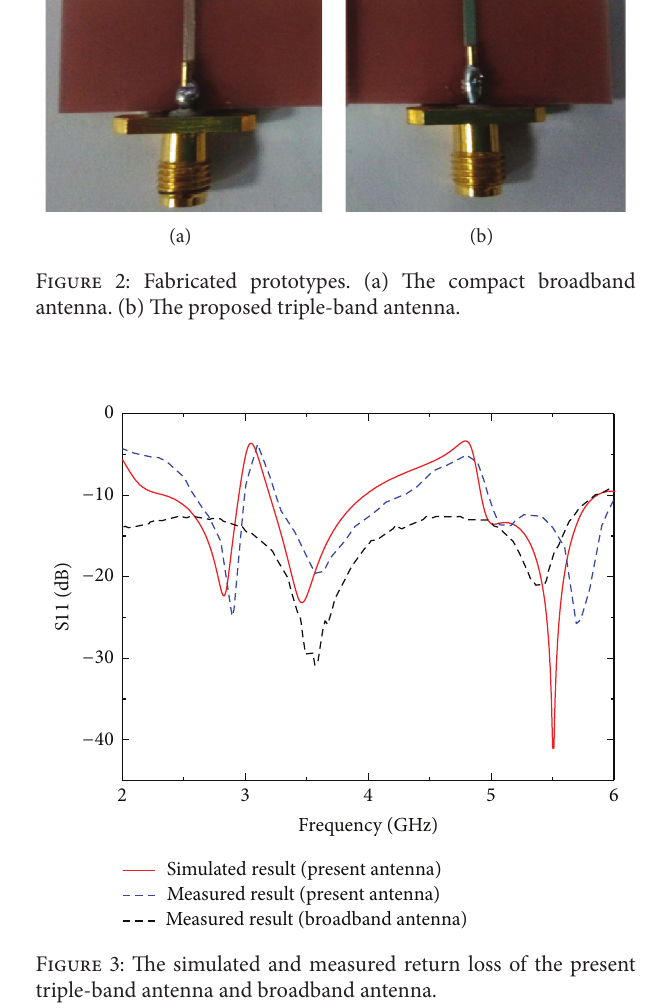
Figure 3: The simulated and measured return loss of the present triple-band antenna and broadband